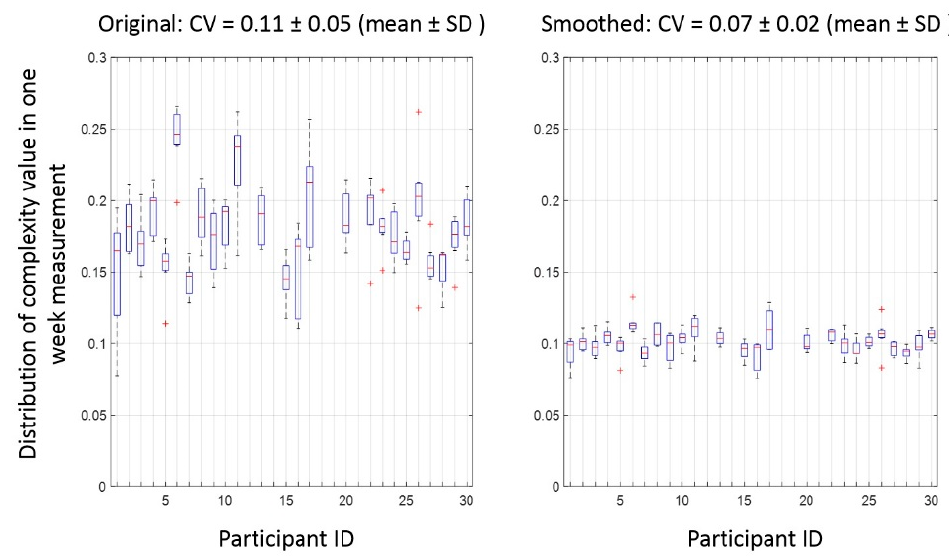
Figure A1. Comparison of cumulated distribution of walking and sedentary bouts before and after smoothing of activity classification output.